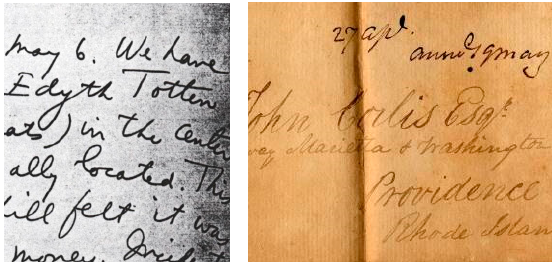
Figure 4. Degraded document images showing variation of contrast: Left image shows higher contrast at the left edge while lower contrast is shown at the right edge of image. The right image depicts low contrast in the middle and high contrast in both left and right edges.